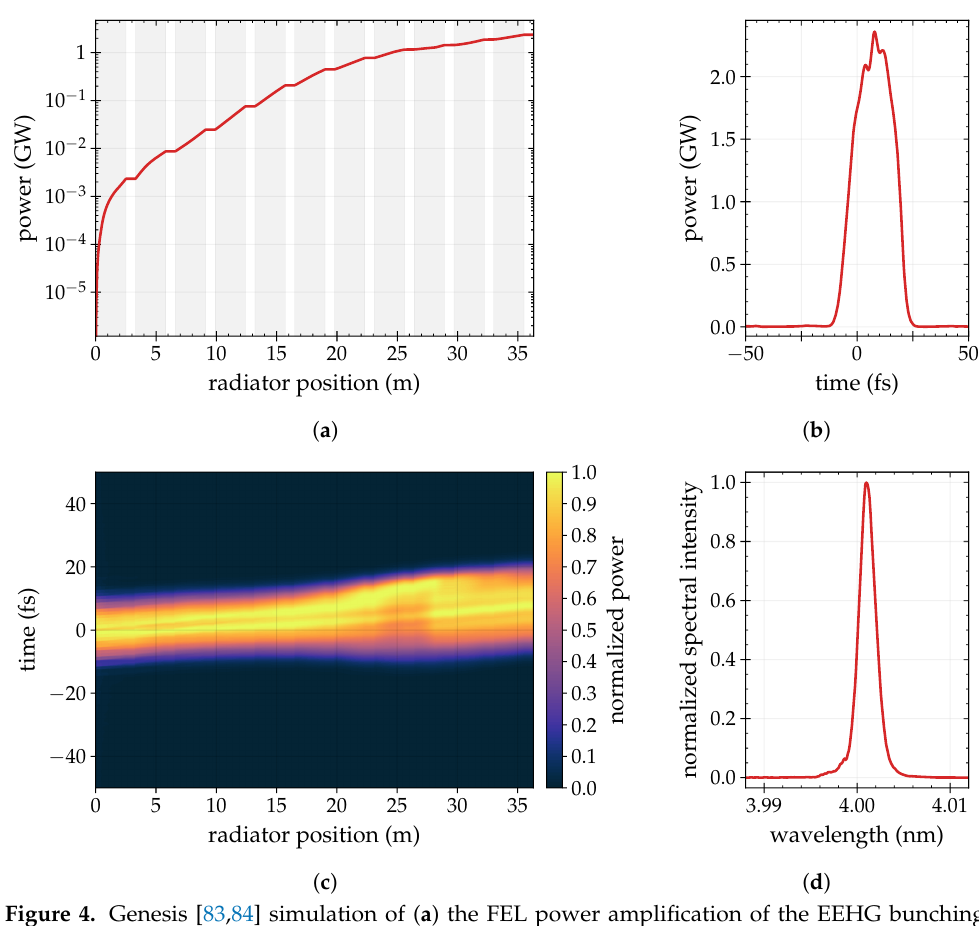
Figure 4. Genesis [83,84] simulation of ( a ) the FEL power amplification of the EEHG bunching in the FLASH1 radiator (grey and white areas represent active undulator and drift, respectively); ( b ) temporal and ( d ) spectral profiles of the FEL at the exit of the radiator. ( c ) Evolution of the FEL temporal profile (normalized) along the radiator